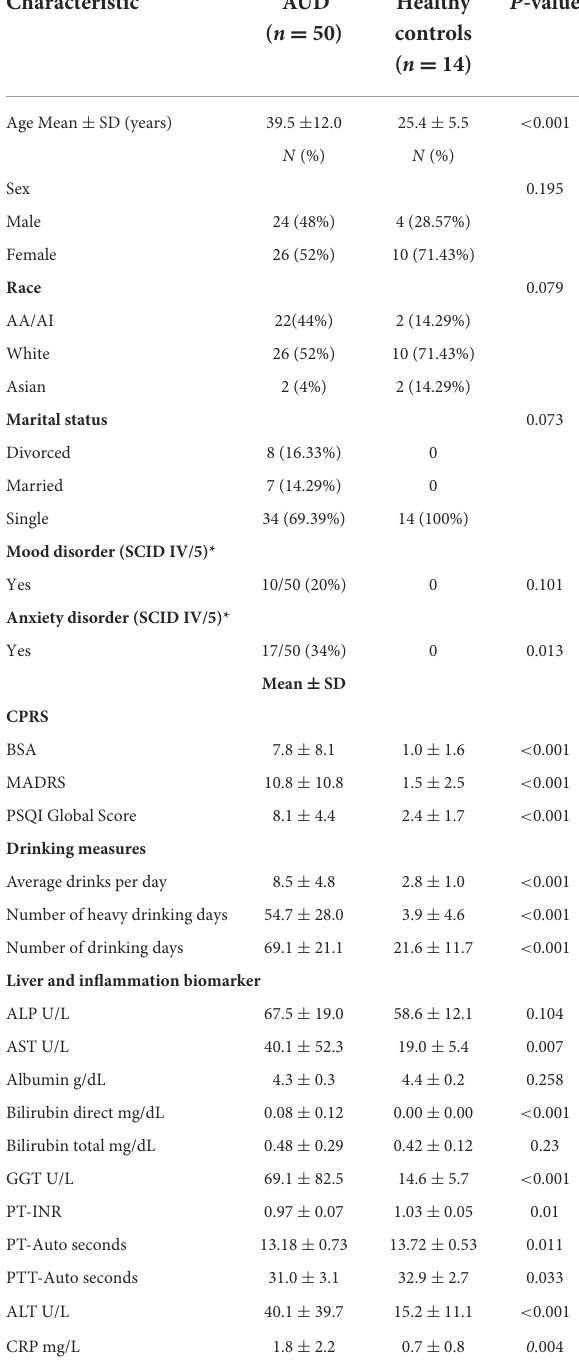
TABLE 2 Demographic and clinical characteristics of study population ( n = 64).